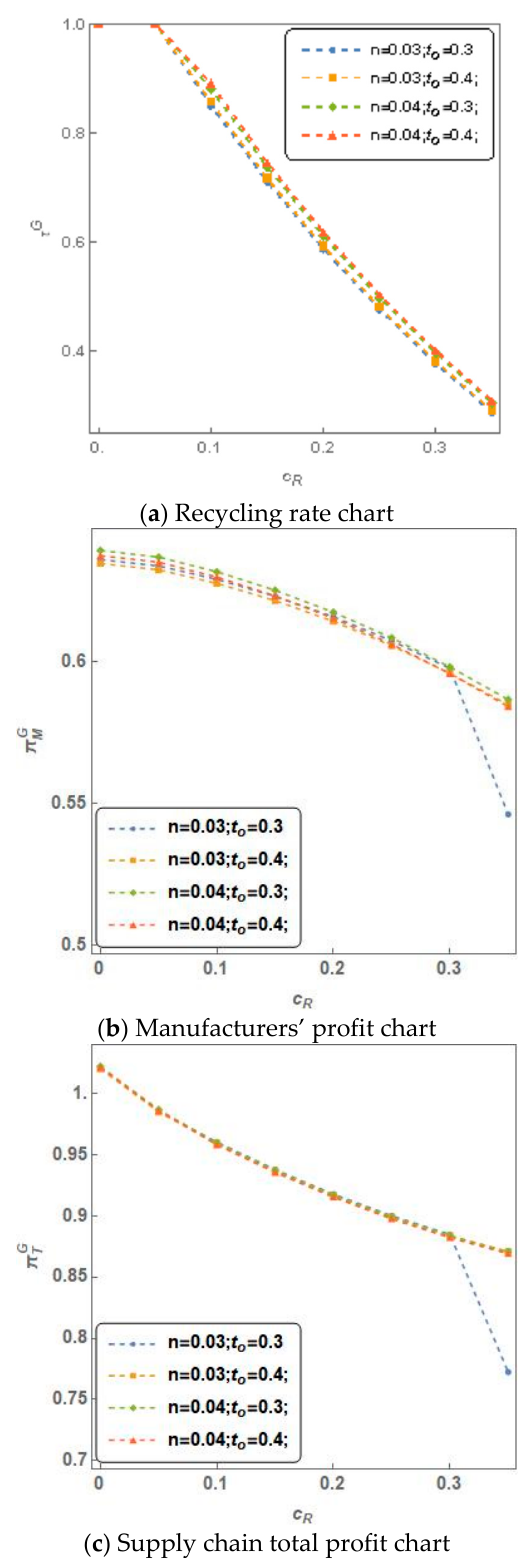
Figure 5. Impact of η , τ 0 . ( a ) Recycling rate chart; ( b ) Manufacturer’s profit chart; ( c ) Supply chain total profit chart.